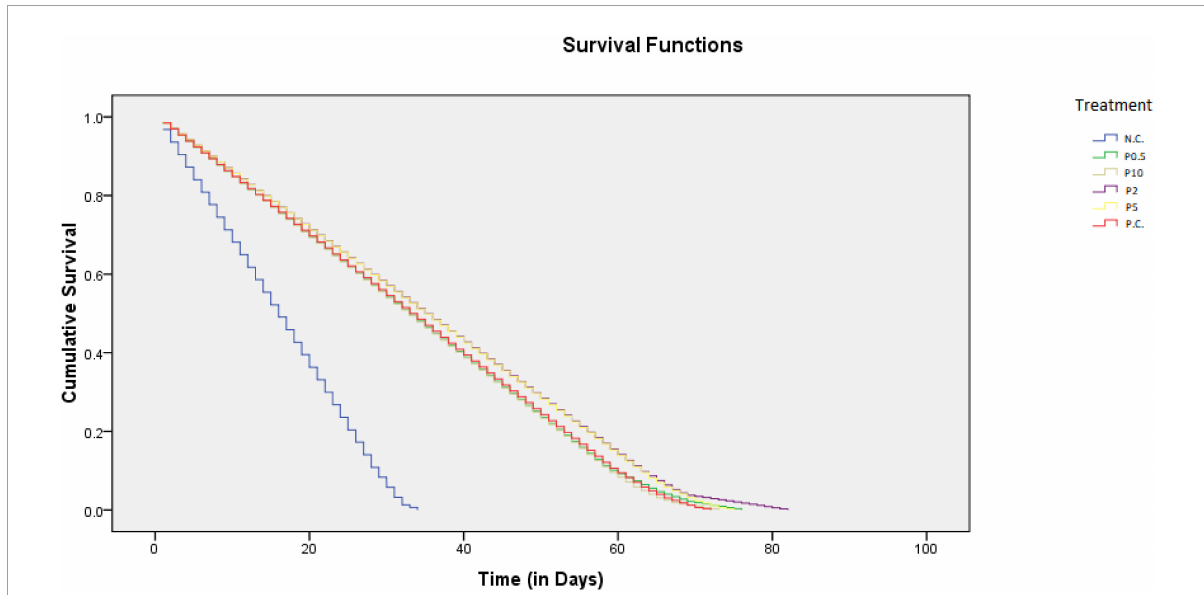
FIGURE4 Progress of the survival of the honey bees belonging to different feeding groups over